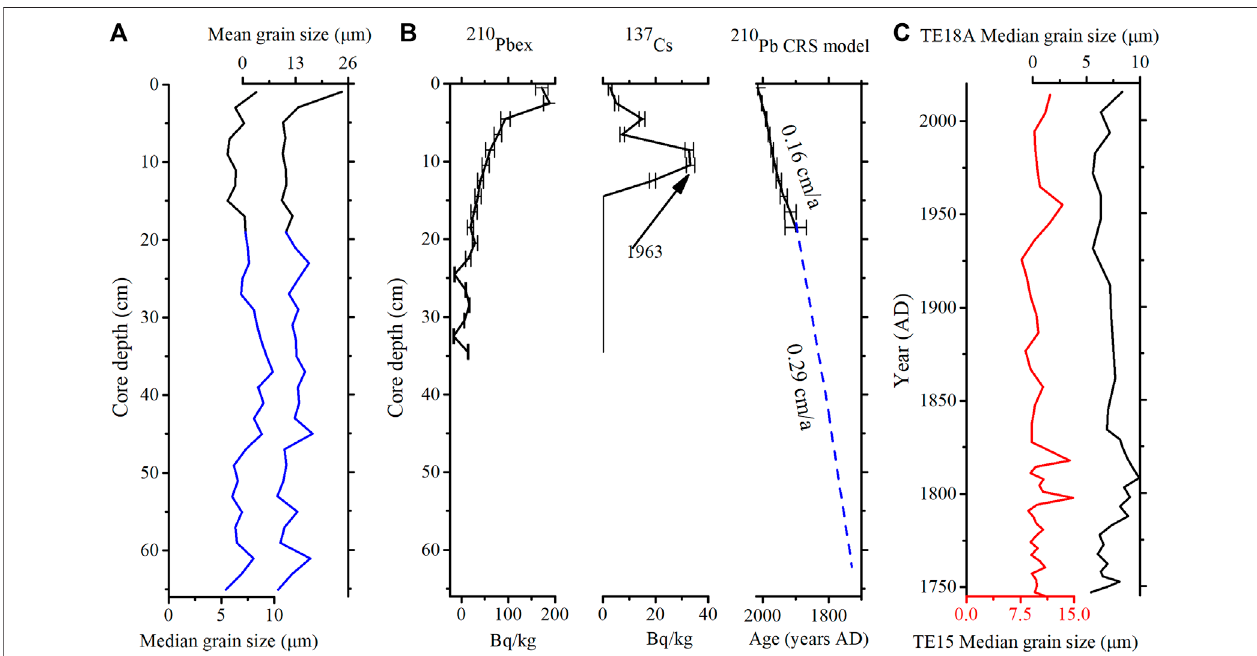
FIGURE 2 | Age model for core TE18A from Tian ’ E Lake. (A) Depth pro fi les of median grain size and mean grain size of TE18A. Parts below 19 cm are shown in blue. (B) 210 Pb and 137 Cs activity and the constant rate of supply age-depth model. (C) Comparison of the median grain sizes of TE15 and TE18A.